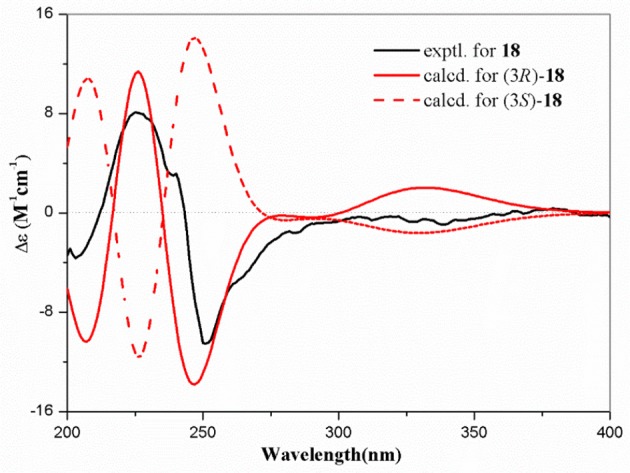
Experimental and calculated ECD spectra of 18.